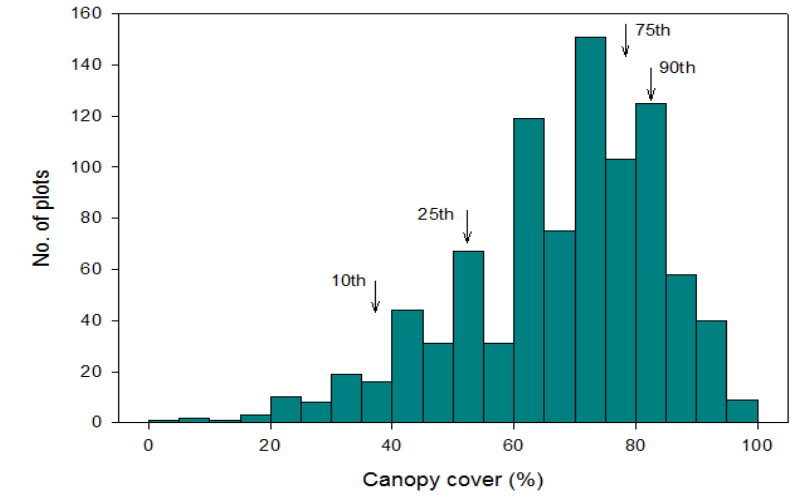
Figure 2. Frequency distribution of canopy cover in plots with seedlings present ( n = 913). Arrows indicate the position of different